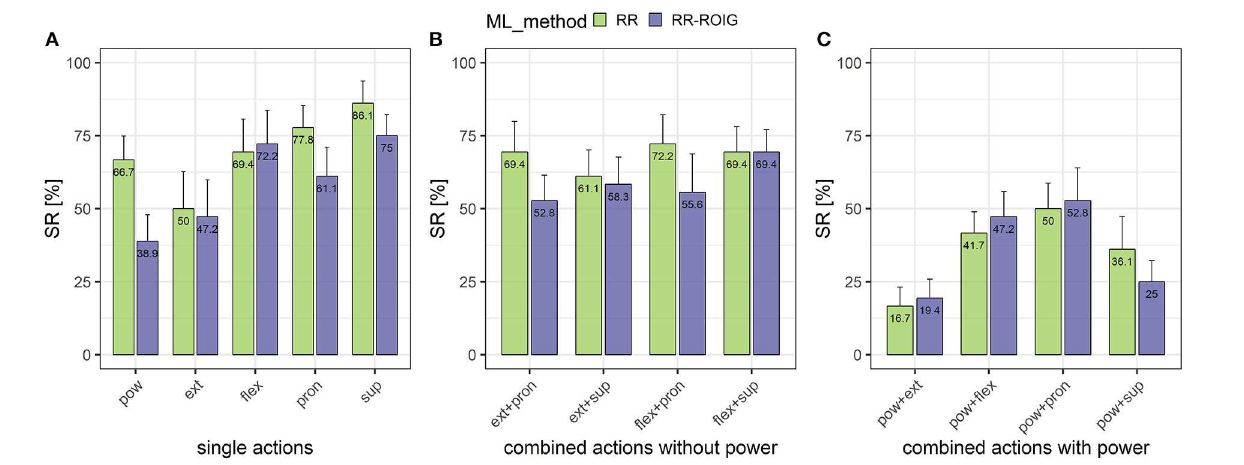
FIGURE 10 | Means and standard errors of the success rates per actions separated into 3 groups: single actions (A) , combined actions without the power grasp (B) and combined actions including the power grasp (C)